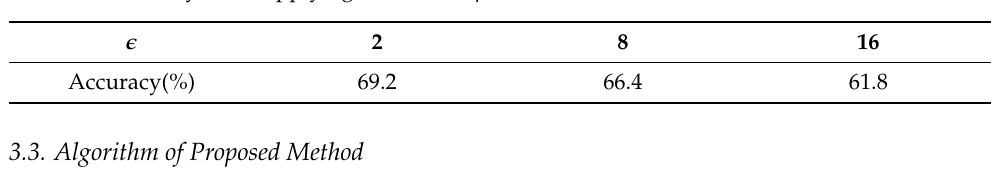
Table 10. Accuracy when applying ideal α and β